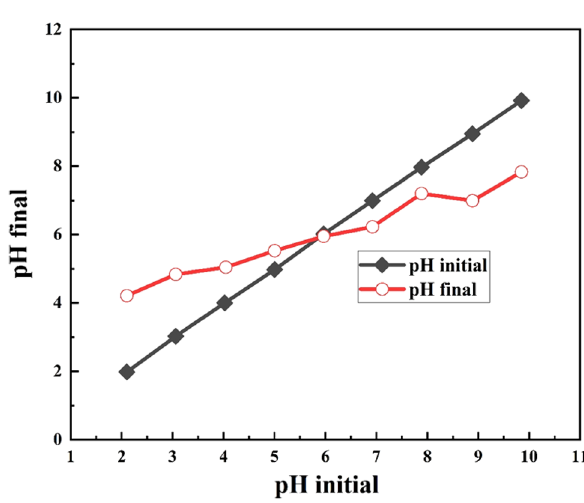
Figure 10. The pHpzc of